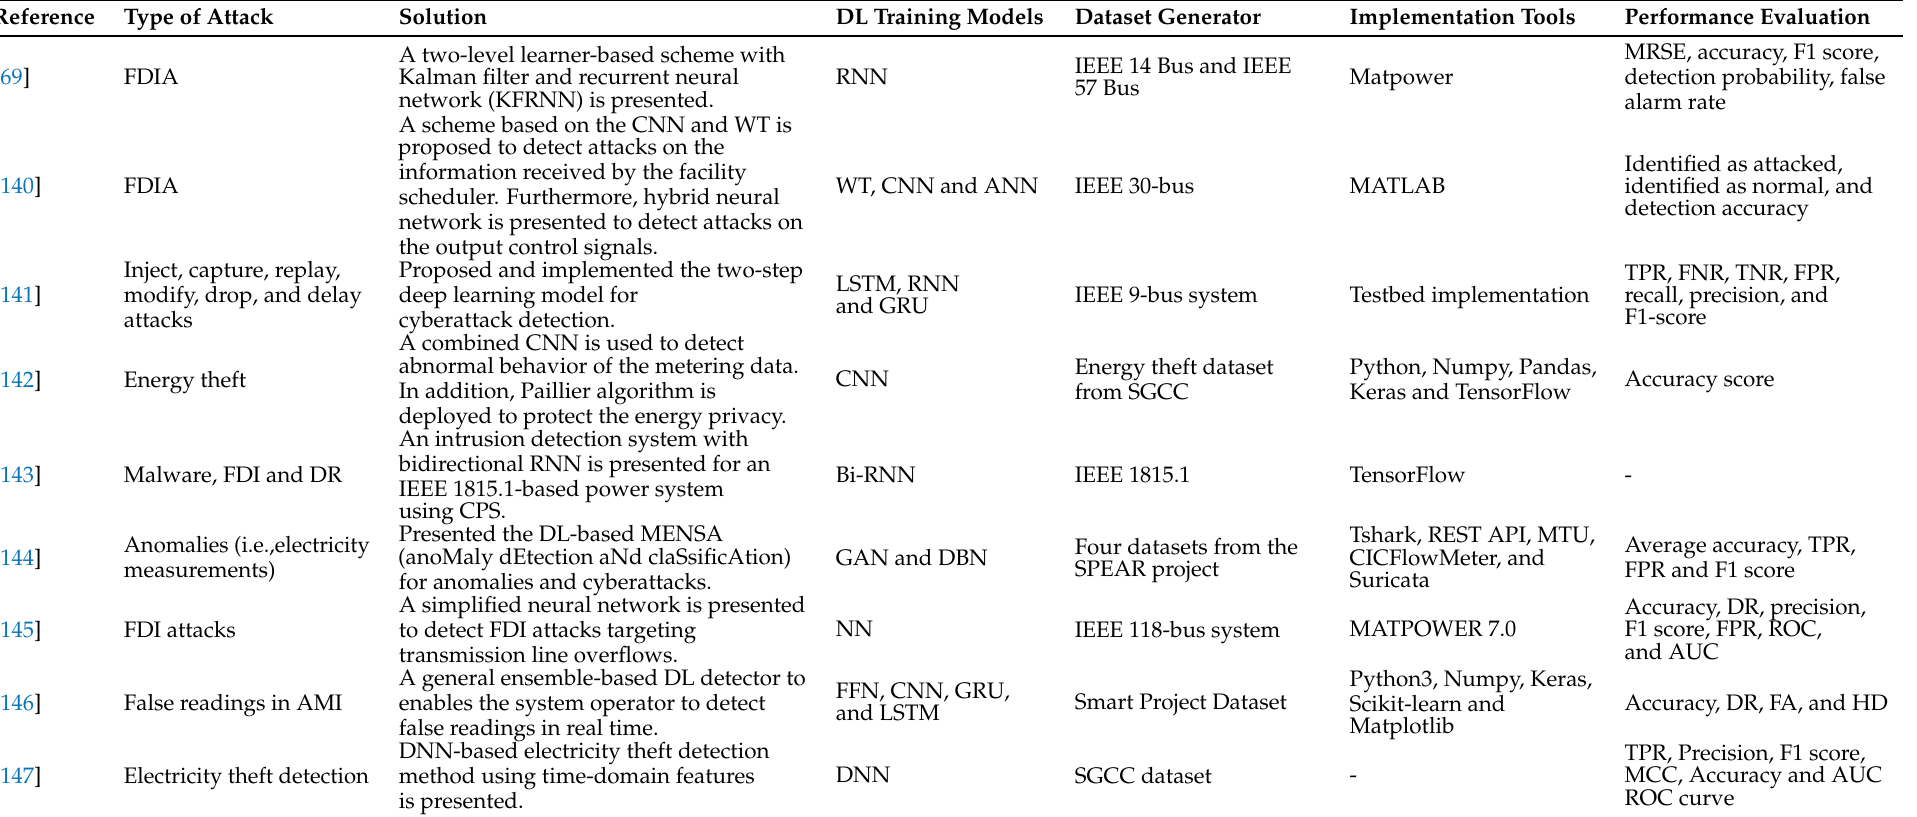
Table 11. Deep learning based attack detection techniques for cybersecurity in smart